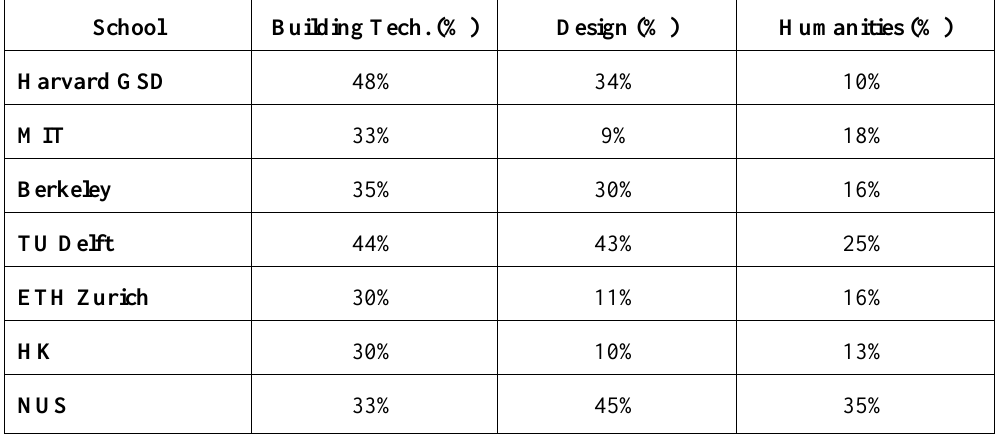
Table 1. Percentage of Environmentally Aware Lectures by Area